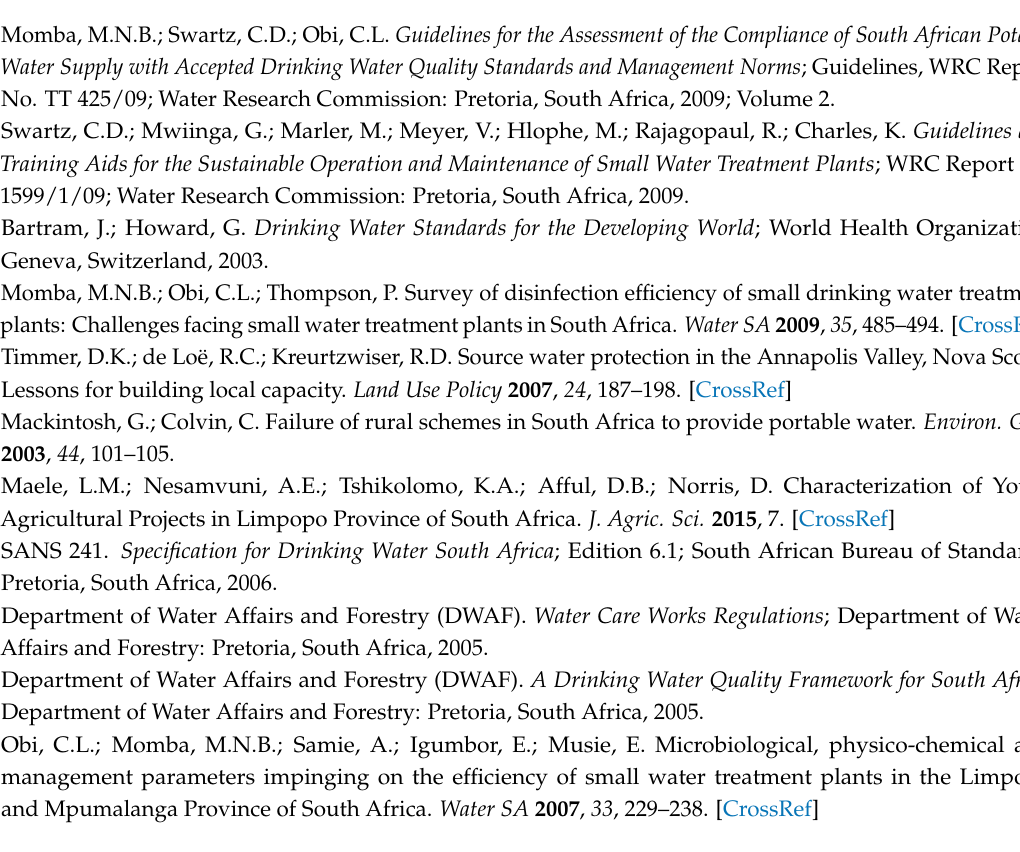
Table S1: Non-technical compliance 2009 and 2011, Table S2: Ranking of the Problem Areas in Priority Order after the first